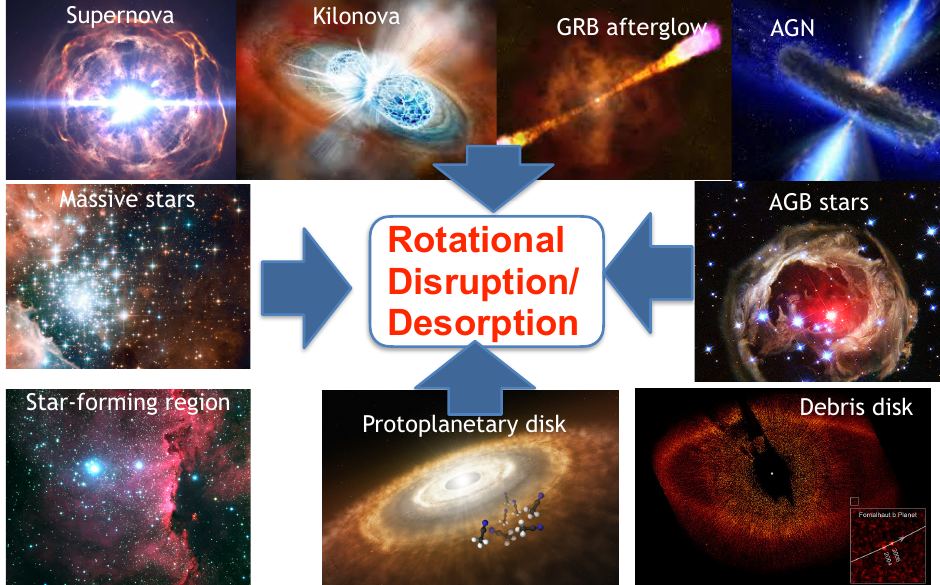
Figure 14. Illustration of astrophysical environments where rotational disruption and desorption of dust and ice due to radiative torques are most important thanks to strong radiation fields. The interstellar medium of our galaxy and other galaxies is not shown here, but RATD is also important, especially for starburst and high-z